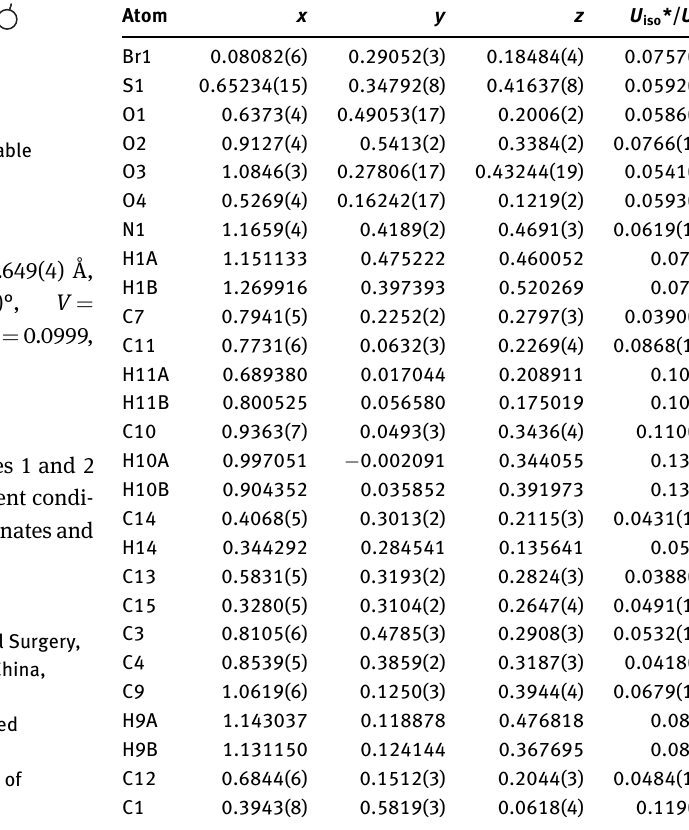
Table 2: Fractional atomic coordinates and isotropic or